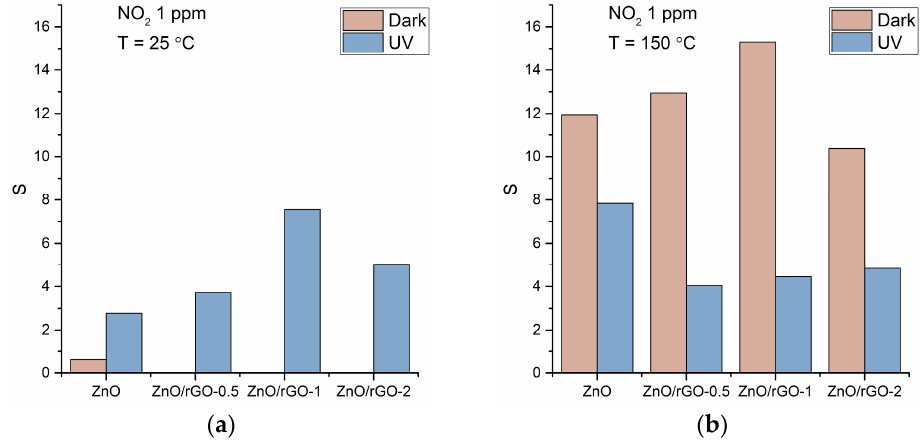
Figure 10. S ensor response of ZnO and ZnO/rGO composites when detecting 1 ppm NO 2 in dark Figure 10. Sensor response of ZnO and ZnO/rGO composites when detecting 1 ppm NO 2 in dark conditions and under UV illumination at 25 °C ( a ) and 150 °C ( b ). conditions and under UV illumination at 25 ◦ C ( a ) and 150 ◦ C ( b